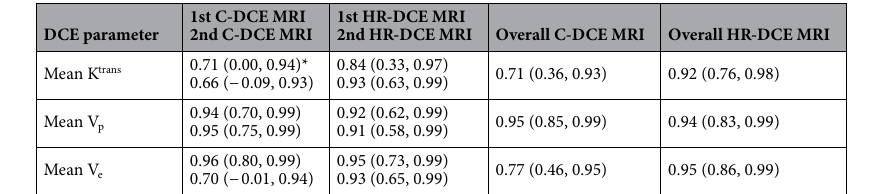
Table 2. ICCs of DCE parameters derived from C-DCE and HR-DCE MRI in patients with glioblastoma ( n = 7) using individual AIFs. ICC intraclass correlation coefficient. *ICC with 95th percentile confidence